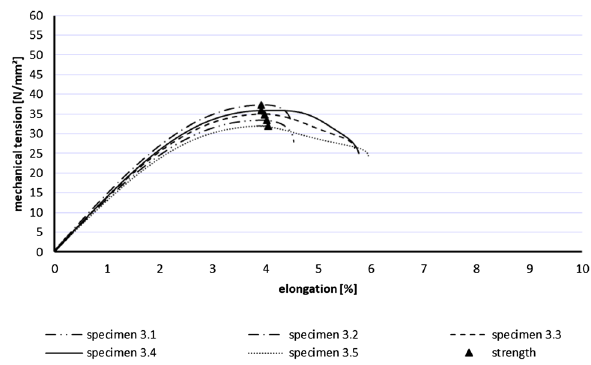
Fig. 16 Stress–strain diagram sample 3 (100% recycled material)